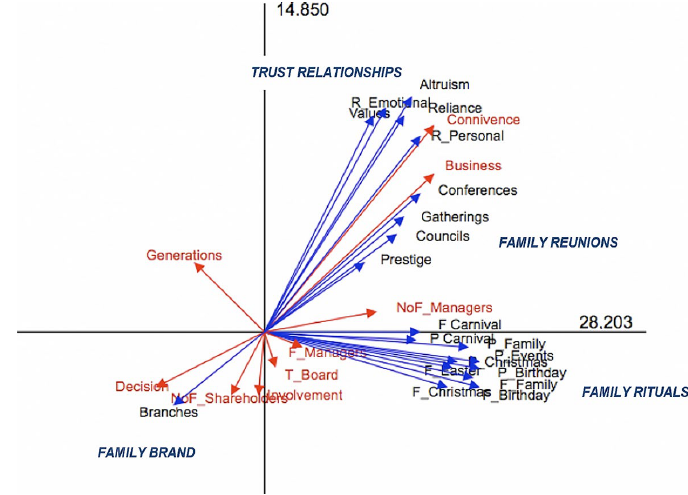
Fig. 2. Representation of variables in the PRINCALS factor plan Note: Blue vectors refer to family characteristics variables; red vectors refer to the governance mechanisms